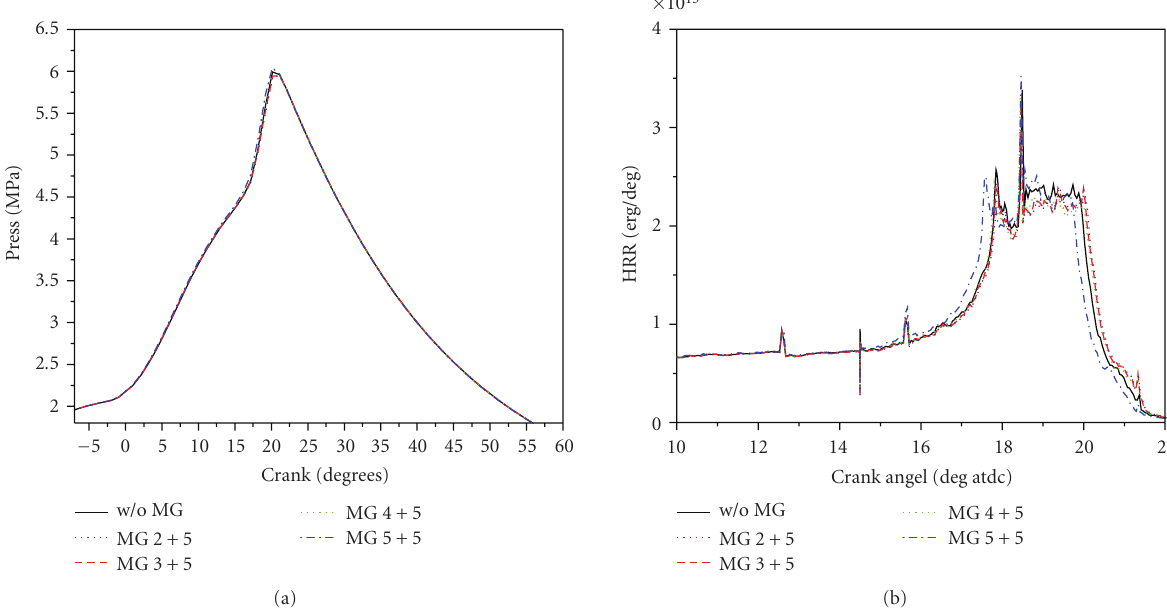
Figure 9: Pressure and HRR of SI engine simulated using two-zone MG model with di ff erent searching levels and skipping high-temperature cells ( T > 800 K) in the unburned region.